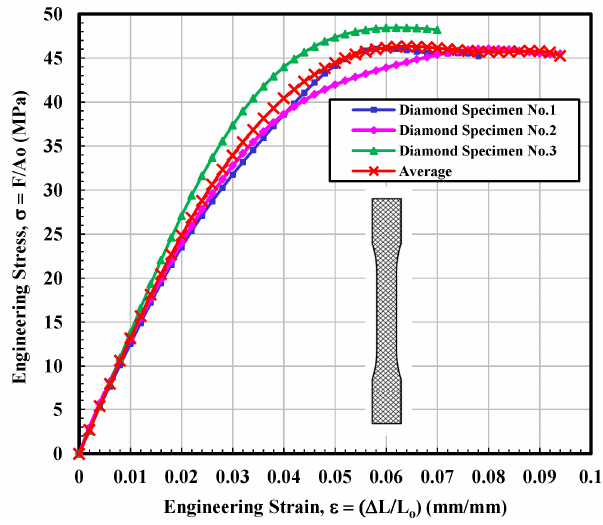
Figure 7. Engineering stress–strain curves for diamond infill test specimens. Table 3. Experimental results of mechanical properties for diamond infill test specimen configuration.